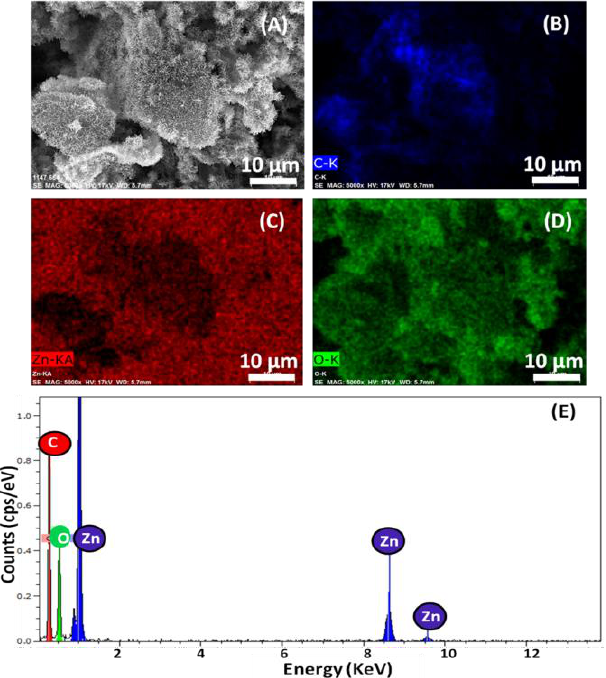
Figure 2. Energy-dispersive X-ray spectroscopy (EDX) elemental analysis performed on the ( A ) ZNGs and elemental mapping for ( B ) carbon, ( C ) zinc, ( D ) oxygen, and ( E ) corresponding EDX spectrum. The X-ray diffraction (XRD) patterns of GNPs, ZnO-NRs and ZNGs are shown in Figure 3. The peak positions of the obtained spectra for samples of ZnO-NRs and ZNGs are in excellent agreement with the published Joint Committee on Powder Diffraction Standards (JCPDS) card 036-1451 of wurtzite structure of ZnO, with lattice constants a = 3.25 Å and c = 5.17 Å . The spectrum of the pristine GNPs consists of a strong graphitic peak at its 2θ value of 26.53° and in secondary peaks from 40° to 60° [36]. The same peaks are present in the XRD pattern of sample ZNGs. No diffraction peaks of impurity were detected, suggesting that the synthesized nanomaterials are of high-purity. Further, the sharp and intense diffraction peaks indicate the highly crystalline nature of the produced nanostructures.